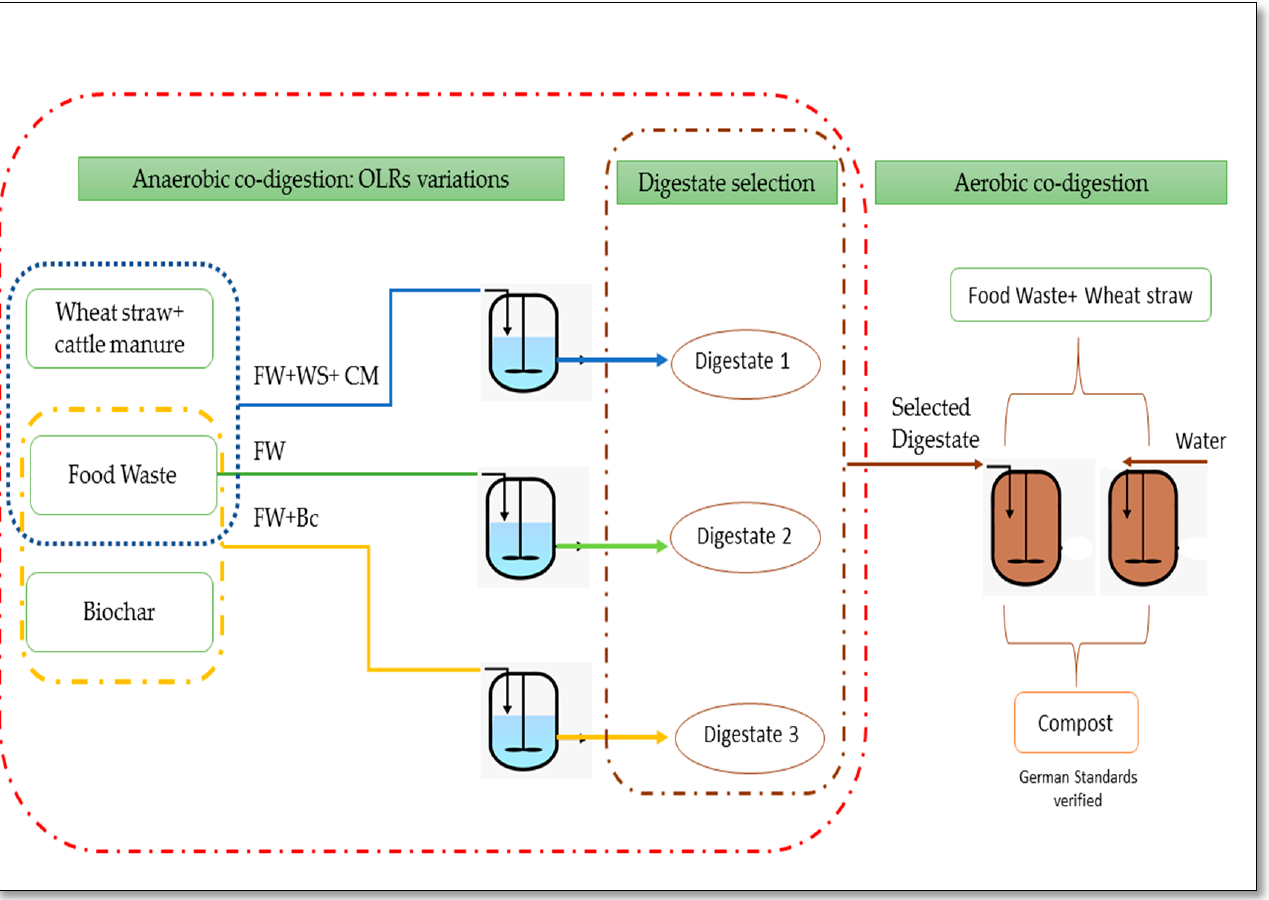
Figure 1. Conceptualization of the overall Renew_Value approach.